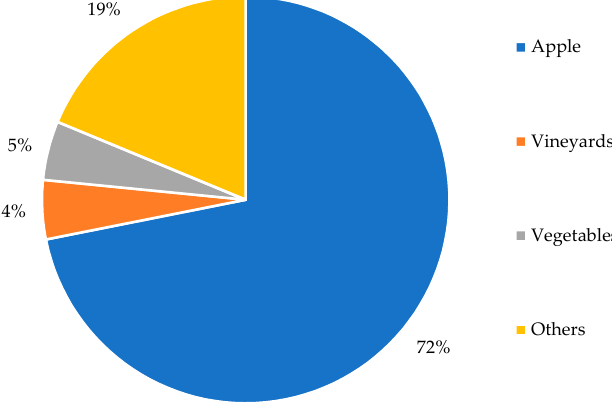
Figure 6. A display of the proportion of reports from different agricultural cultivations, with n = 64 reports from agricultural cultivations.